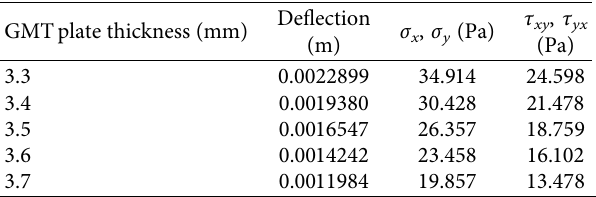
Table 1: Maximum deflection and stress values for different